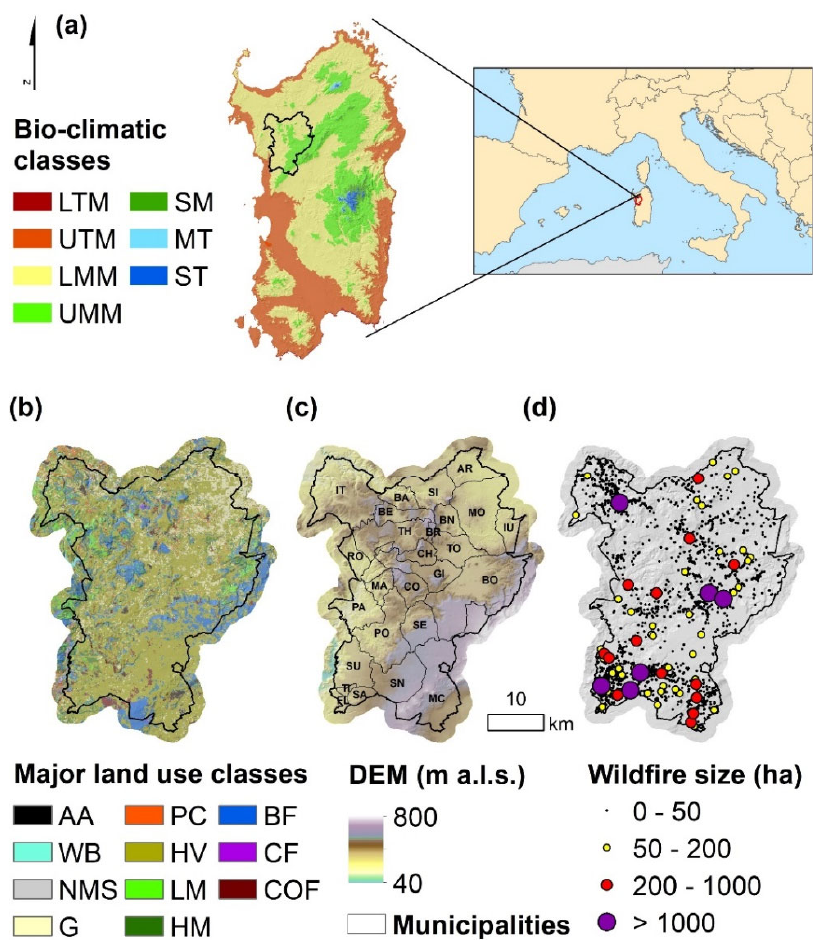
Figure 1. Weather zones (adapted from Sardinia Environmental Protection Agency) and bio ‐ climatic classification of Sardinia, the black polygon designates the study area ( a ); major land use classes of the study area, according to the 2008 Sardinia Land Use Map [62] combined with the 10 m Land Cover Map of Europe, 2017 [63] ( b ); digital elevation model map and municipalities boundary of the study area along with the main towns ( c ); historical wildfire ignitions in Sardinia for the period 2003–2019 as a function of the final wildfire size ( d ). AA= anthropic areas; WB = water bodies; NMS = natural material surfaces; G = grasslands; PC = permanent crops; HV = herbaceous vegetation (pastures and mixed agricultural areas); LM = low Mediterranean maquis; HM = high Mediterra ‐ nean maquis; BF = broadleaf forests; CF = conifer forests; COF = cork oak forests. LTM = lower ther ‐ momediterranean; UTM = upper thermomediterranean; LMM = lower mesomediterranean; UMM = upper mesomediterranean; SM = supramediterranean; MT = mesotemperate; ST = supratemperate. AR = Ardara; BA = Banari; BE = Bessude; BR = Borutta; BN = Bonnanaro; BO = Bonorva; CH = Cher ‐ emule; CO = Cossoine; FL = Flussio; GI = Giave; IU = Ittireddu; IT = Ittiri; MA = Mara; MC = Macomer; MO = Mores; PA = Padria; PO = Pozzomaggiore; RO = Romana; SA = Sagama; SE = Semestene; SN = Sindia; SI = Siligo; SU = Suni; TH = Thiesi; TI = Tinnura; TO = Torralba.